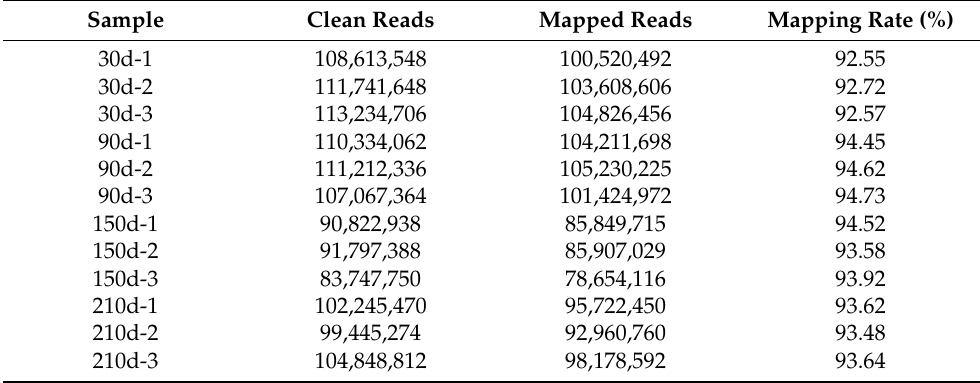
Table 3. Statistics of mapping to reference